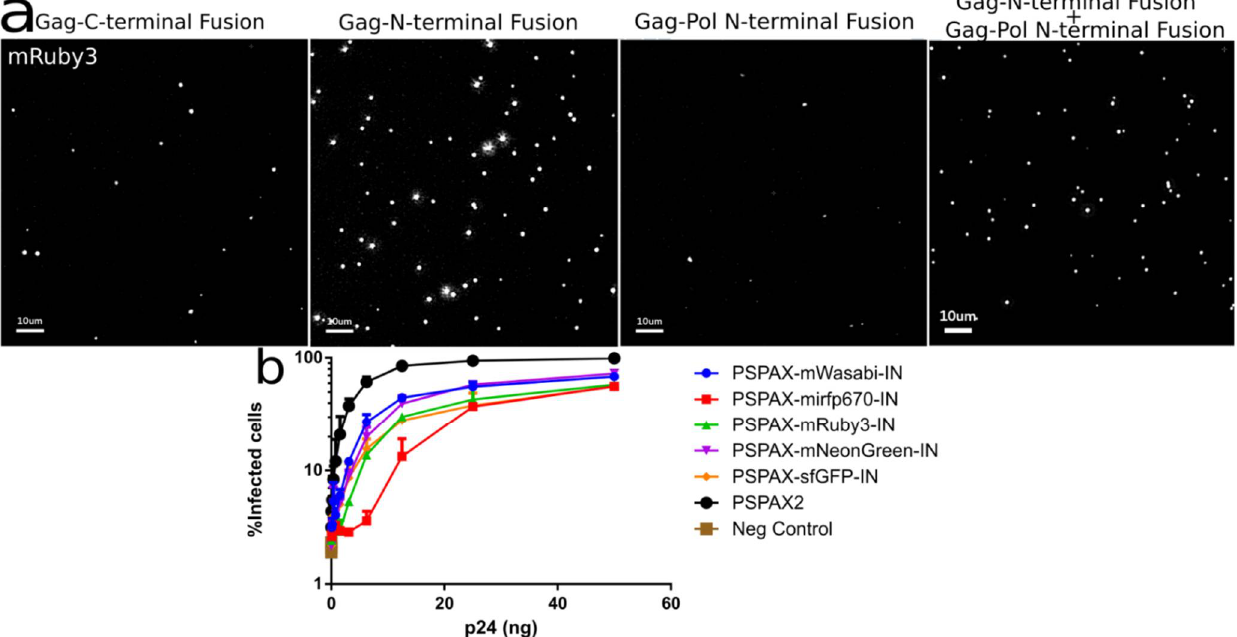
Figure 5. ( a ) Intensity of different IN labeled constructs by viral particle spinning on glass, Gag-INmRuby3, Gag-mRuby3IN and psPAX2-mRuby3IN ( b ) Fully labeled IN in Pol can integrate into 293 Affinofile cells at a ~70 to 80% level while compared with unlabeled wild-type IN. Error Bars represent standard deviation between two independent experiments. Kruskal – Wallis test shows a ** p -value < 0.01 between infection samples and non-infected cells (Neg. Control), all ranked Dunn’s multiple comparisons between all labelled infections do not show statistical significance to the alternative hypothesis that the labeled and unlabeled IN differ in % of infected cells.